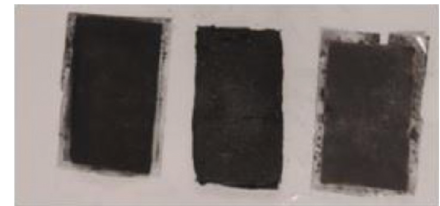
Figure 4: Graphene substrate covered with carbon